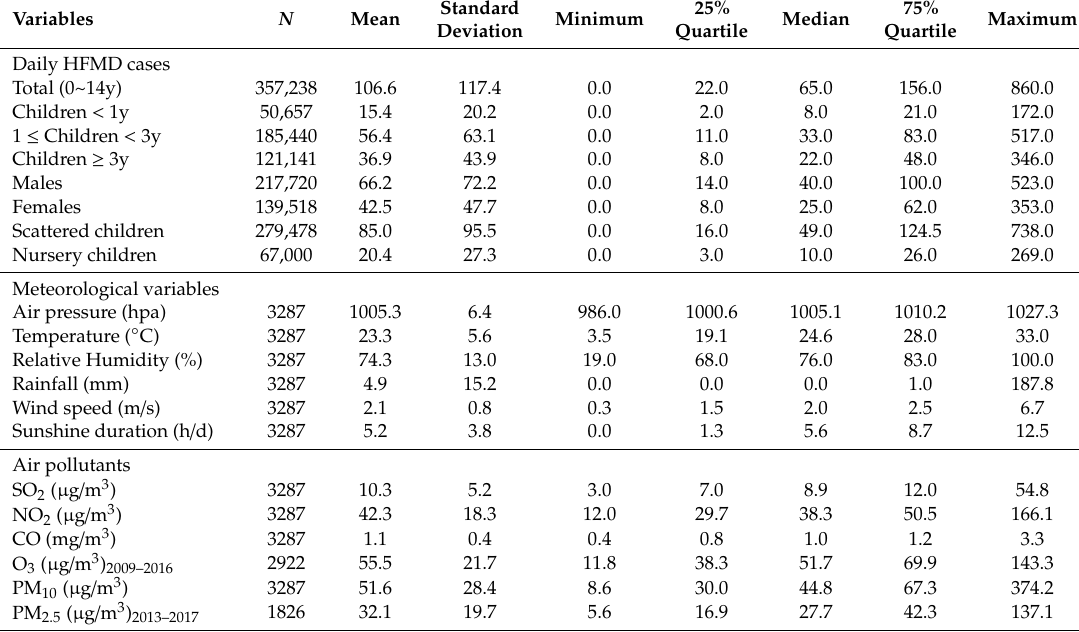
Table 1. Descriptive statistics of daily children hand, foot, and mouth disease (HFMD) cases, meteorological variables and air pollutants in Shenzhen, China,